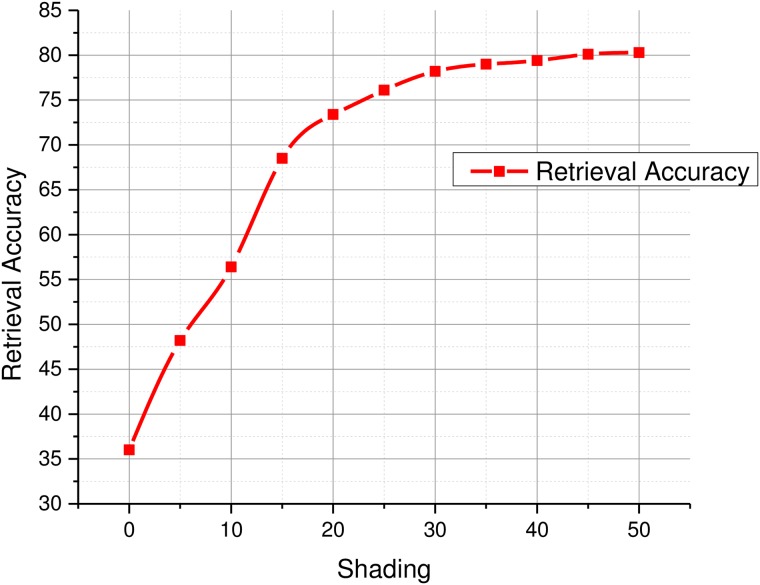
Relationship between partial shading and retrieval performance.